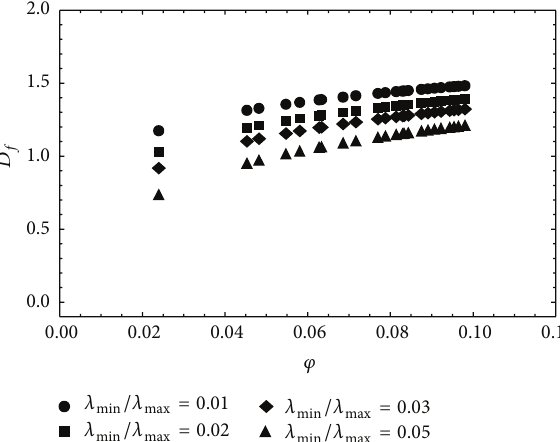
Experimental data Fitting curve Muller and McCauley ( 1992 ) Figure 3: Fitting curve based on the Muller and McCauley [41] model.